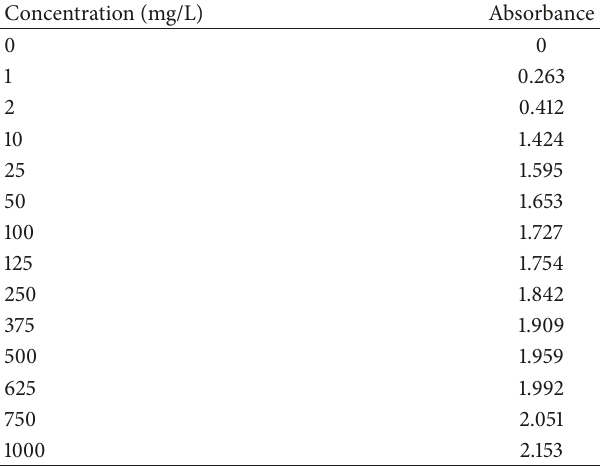
Table 1: Concentration variation with absorbance for the methylene blue solutions, methylene blue wavelength (665 nm).